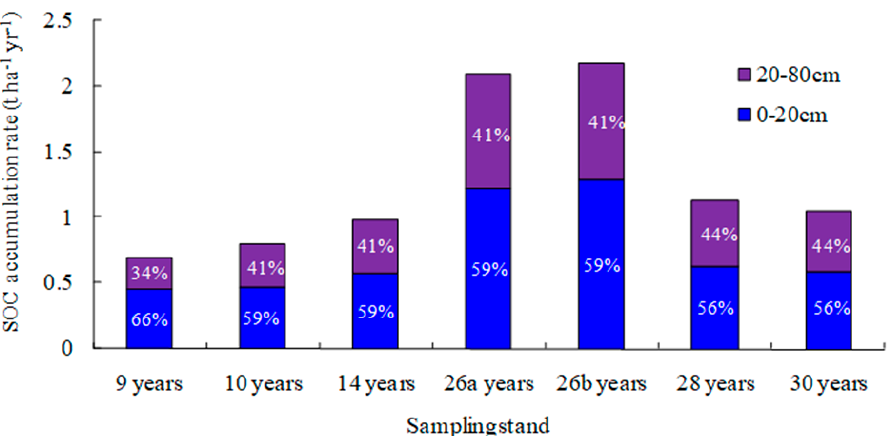
Figure 2. Soil organic carbon (SOC) accumulation rate of mixed plantations, including surface soil (0–20 cm) and deep soil (20–80 cm).